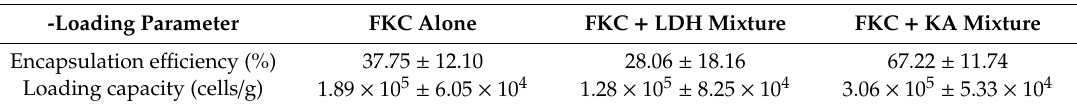
Table 2. Encapsulation efficiency and loading capacity of FKC in alginate beads with and without clays nanoparticles.